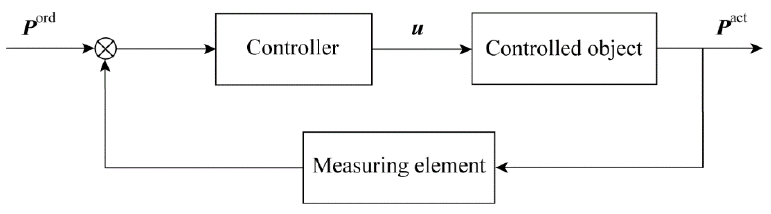
Figure 5. Structure of power user control system.